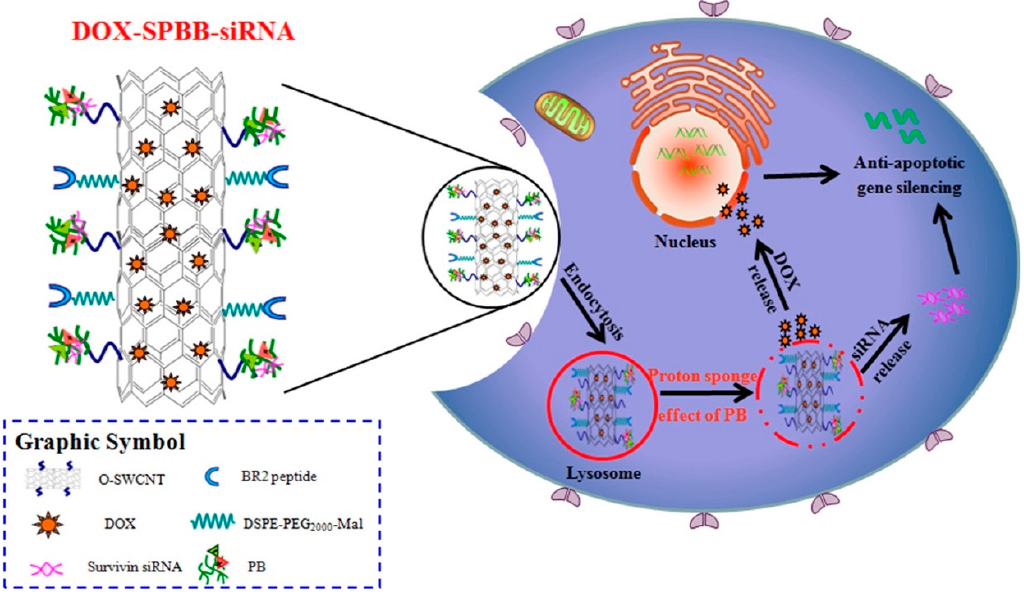
Figure 8. DOX − SPBB − siRNA nanocarriers release DOX and siRNA synergistically in A549 lung cancer cells according to the weak acidity of the tumor microenvironment. Reprinted with permission from Ref. [178]. Copyright 2019, American Chemical Society.